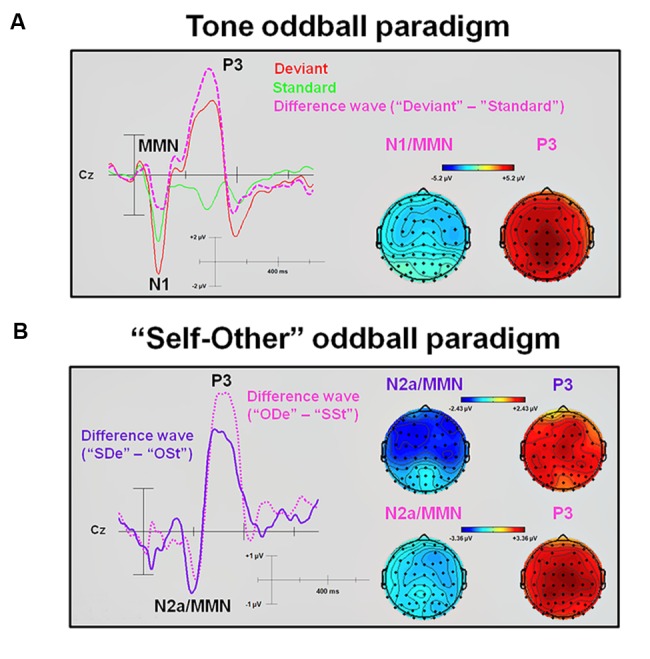
Difference waveforms and corresponding topographic plots obtained from subtracting standards from deviants in the tone and the “Self-Other” oddball paradigm. (A) An averaged ERP waveform and an extracted difference wave (“Deviant” minus “Standard”) at electrode site Cz. In addition, topographic plots of the N1/MMN and P3 peaks are shown. (B) Extracted difference waves (“SDe” minus “OSt” and “ODe” minus “SSt,” respectively) at electrode site Cz. In addition, topographic plots of the N2a/MMN and P3 peaks are shown. MMN, Mismatch negativity.